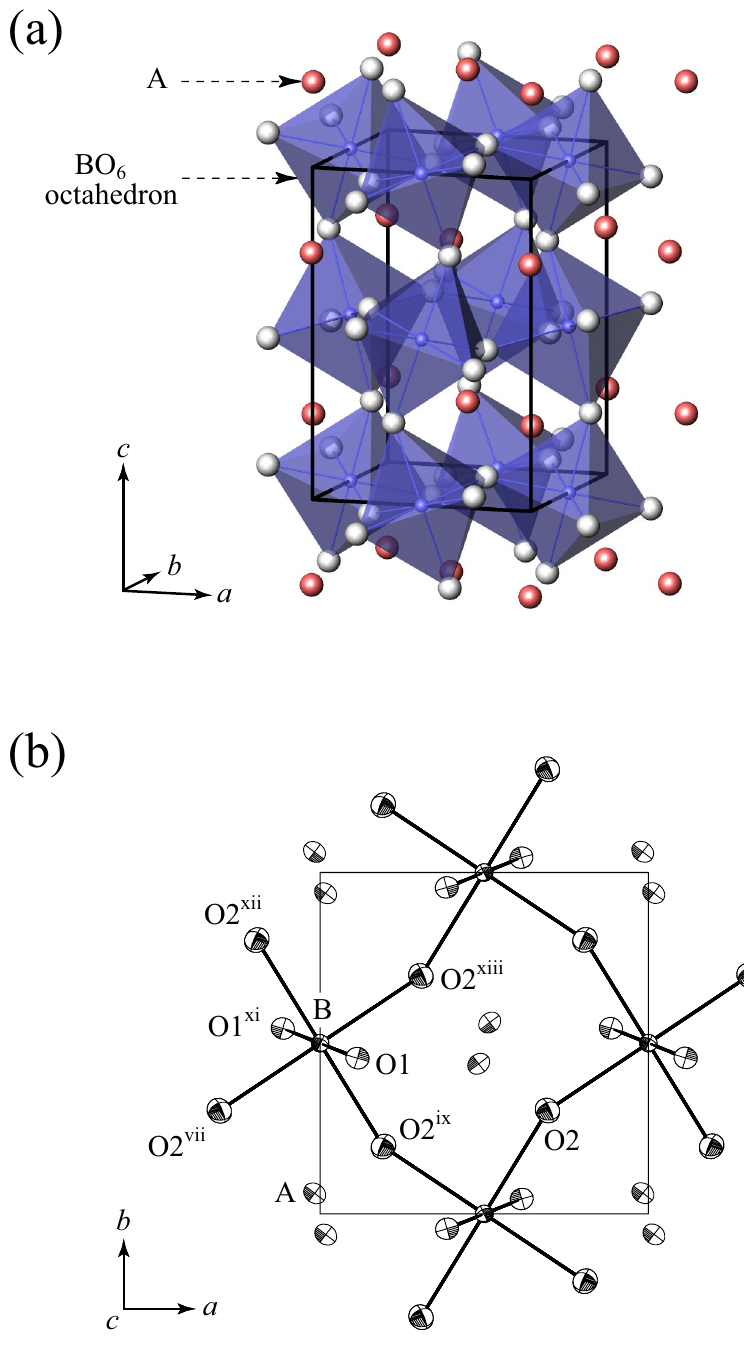
Figure 1. Crystal structure of the present (Fe 3+ , Al)-bearing bridgmanite: ( a ) a view of corner-linked BO 6 octahedra and ( b ) displacement ellipsoids projected along [001]. In ( b ), atoms are drawn at 80% probability level. Symmetry codes for equivalent atoms are as in Table 5. The software ATOMS (Version 5.1, Shape Software, Kingsport, TN, USA, http:// www. shape softw are. com/ 00_ Websi te_ Homep age/) was used for the crystal- structural